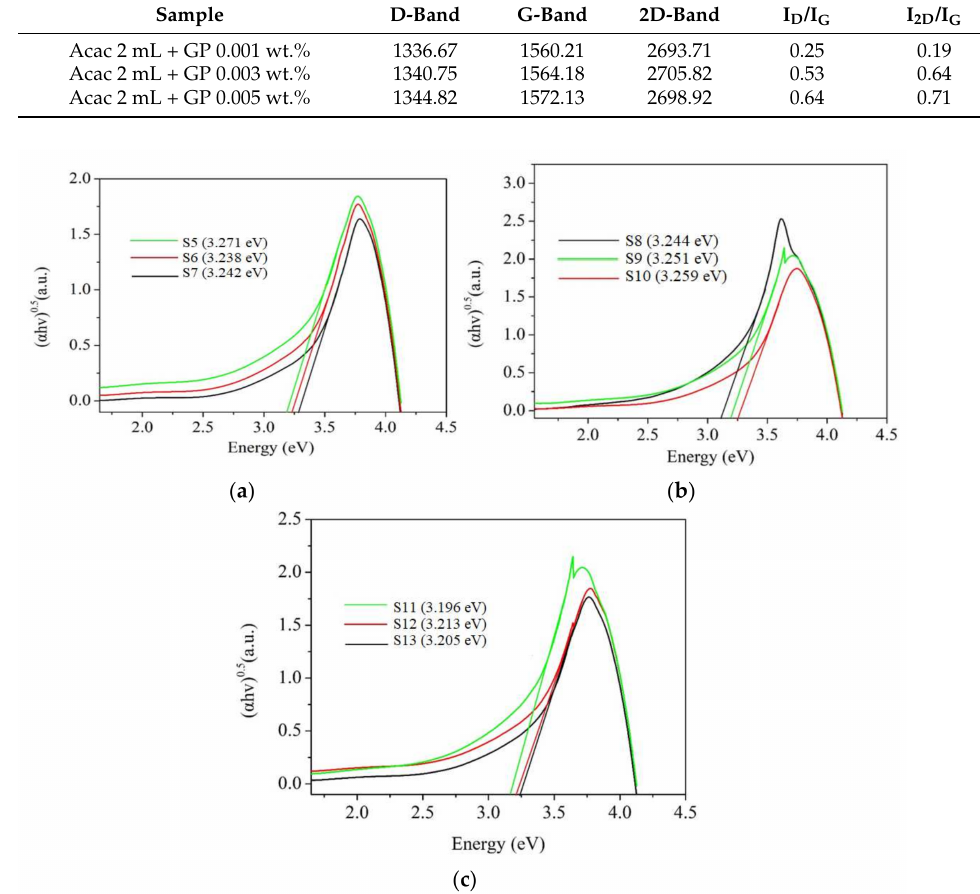
Figure 13. Band gap energy for mixed Acac and GP with a TiO 2 mesoporous layer. ( a ) fixed